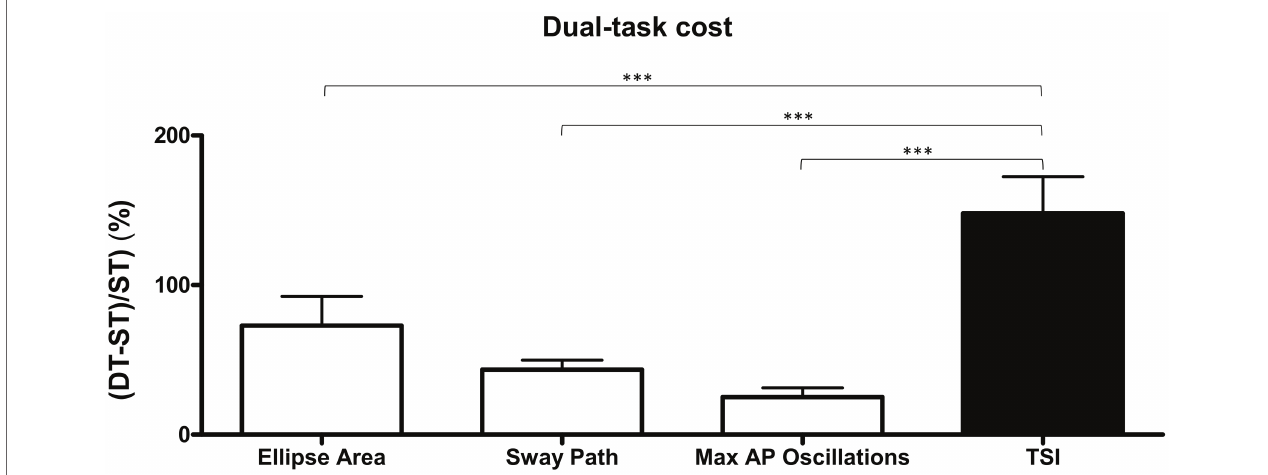
FIGURE 2 | Dual-task cost for static and dynamic postural balance parameters. Black histogram represents the dynamic parameter (TSI, total stability index) while white histograms represent static parameters. DT, dual-task condition; ST, single-task condition. Data are presented as mean ± standard error of the mean (SEM). *** Significantly different ( p <